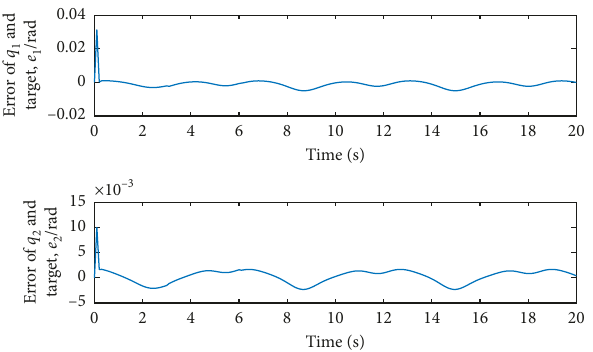
Figure 11: Tracking error under the WMNNAC.